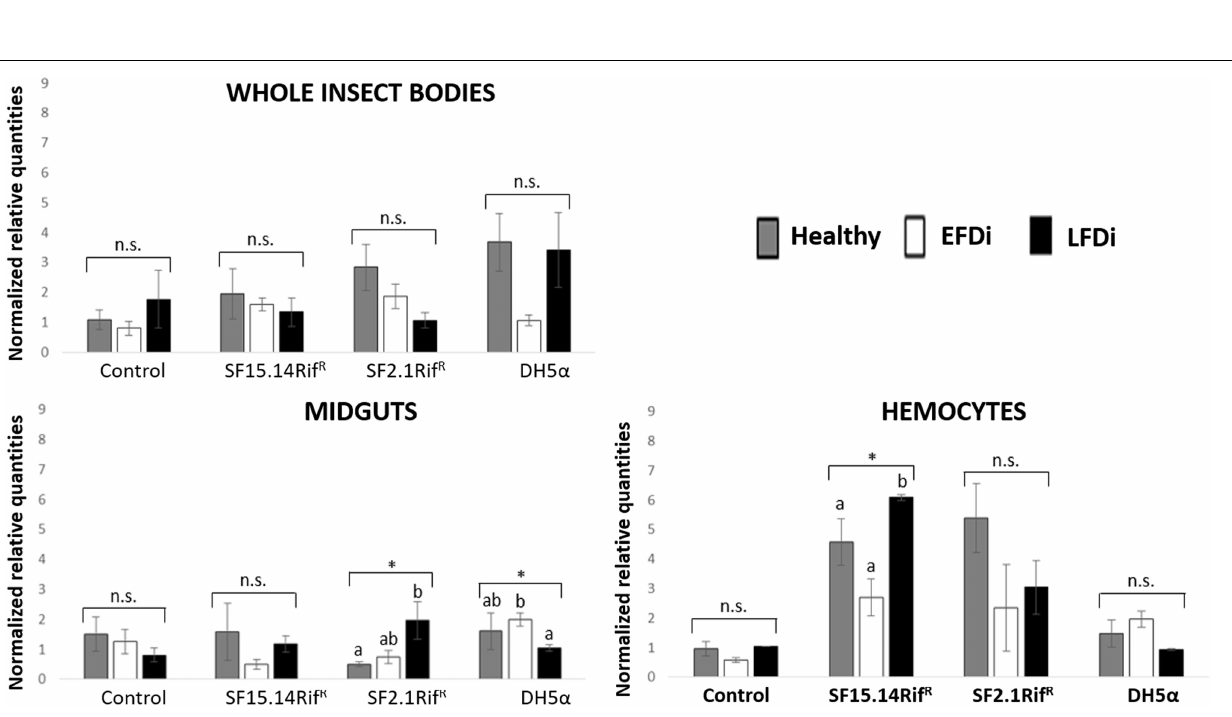
Frontiers in Physiology |